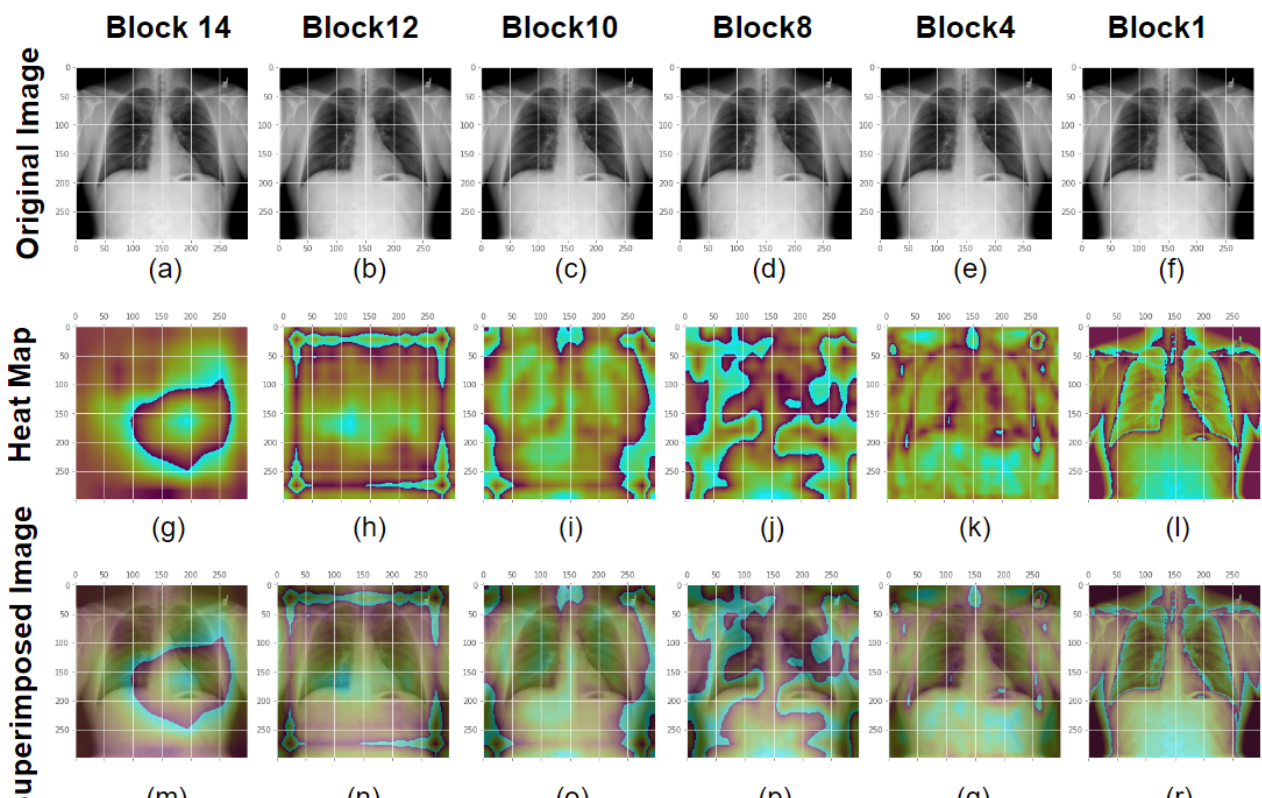
Figure 13. GradCam Analysis for the Xception model for normal class images at different layers. Chest X-ray image from the first row or in images ( a – f ) is in the normal class. The second row or images ( g – l ) depicts the X-ray images after GradCam activation mapping. Activation map and an X-ray picture are overlaid in the third row or images ( m – r ). The block14 separation convolution 2 from the Xception model is displayed in the first column along with the input image, heatmap, and overlay image. The second, third, fourth, fifth, and sixth columns are for Block 12 sepconv2, Block 10 sepconv2, Block8 sepconv2, Block4 sepconv2, and Block1 conv1 respectively. Block 14 detects high-level features and impacts decision making, where as block 1 detects lower-level features such as colors and